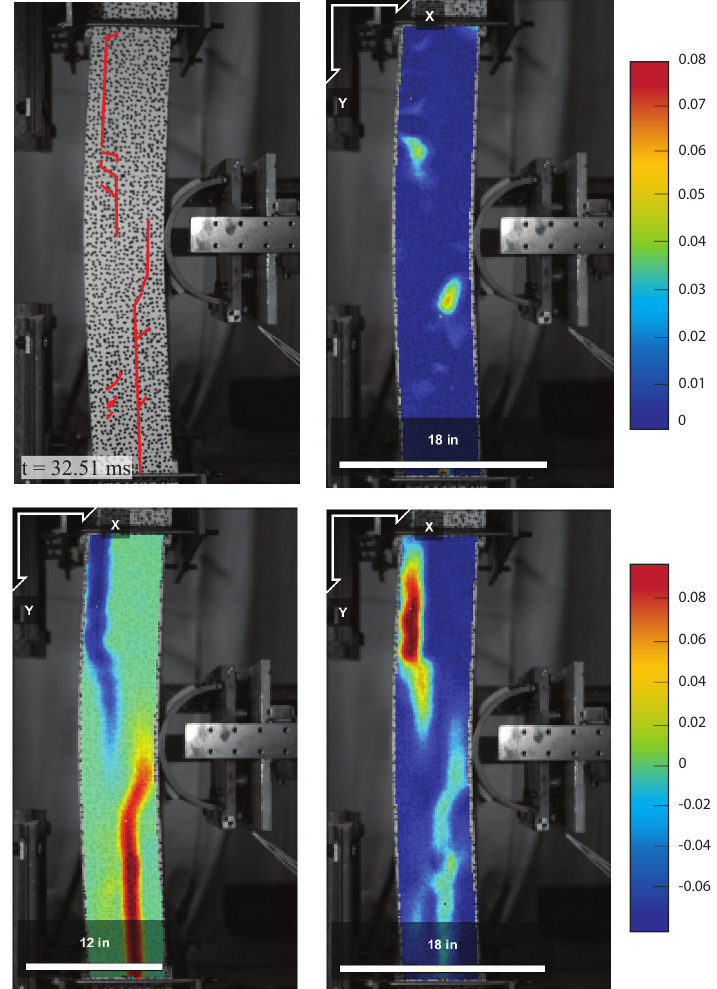
Figure 28. CLT5 − 10 during impulsive loading at t = 32.51 ms. Counterclockwise From Top Left: Photograph of CLT5-10, strain gradients for ε xy , ε xx , and ε yy calculated using